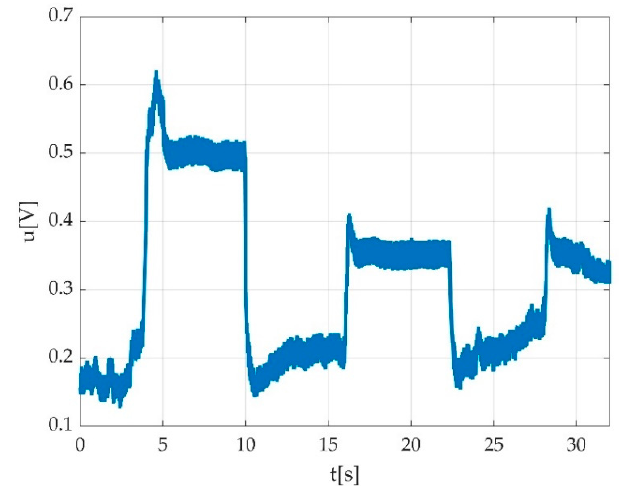
Figure 28. Example of automatically calculated offset steadiness types due to the inability to main- tain constant offset level with progressive decrement of voltage from first to third MVIC due to muscle fatigue.